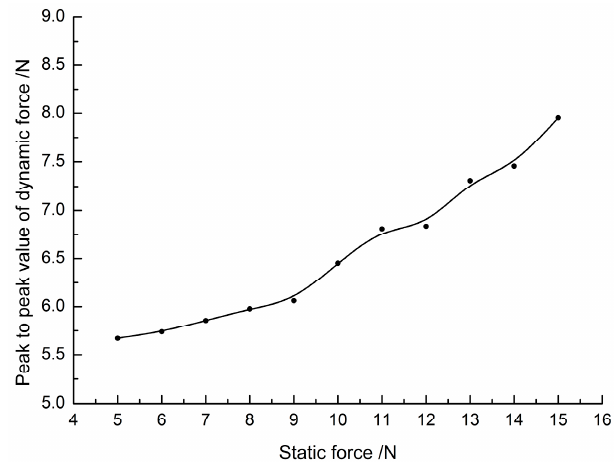
Figure 9. Peak to peak value of measured dynamic force at different preload.